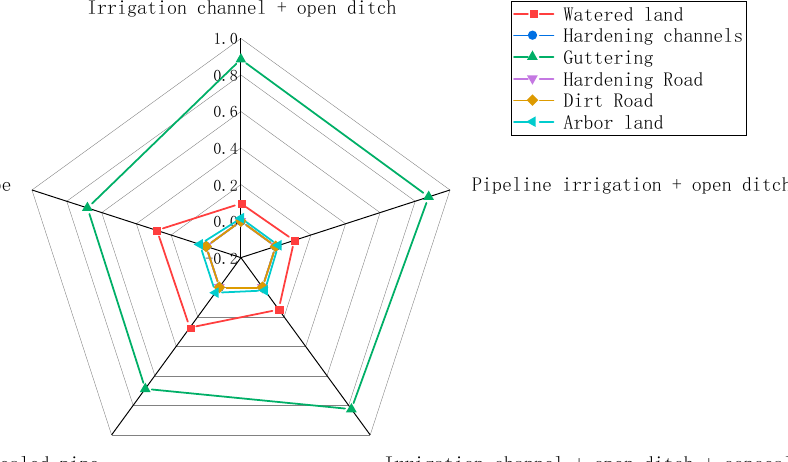
Figure 3. Comparison of sensitivity indices for each land-use type under different irrigation and drainage patterns.